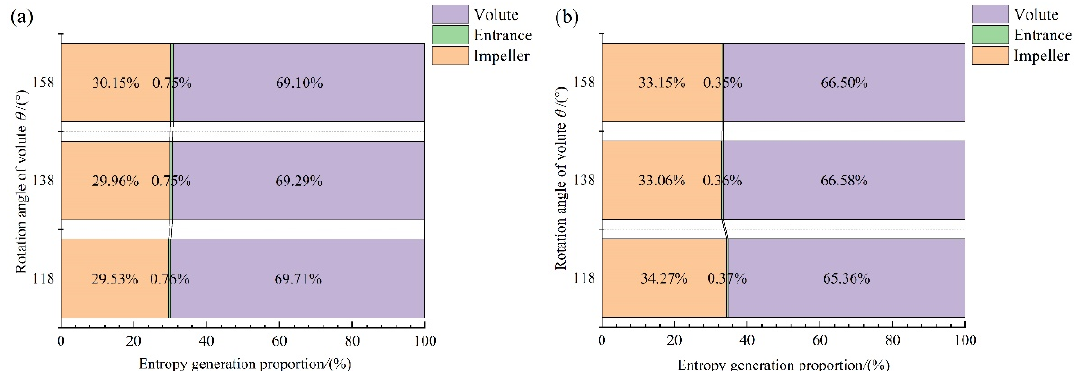
Figure 21. Proportion of entropy production of each flow passage component: ( a ) original scheme and ( b ) optimization scheme.